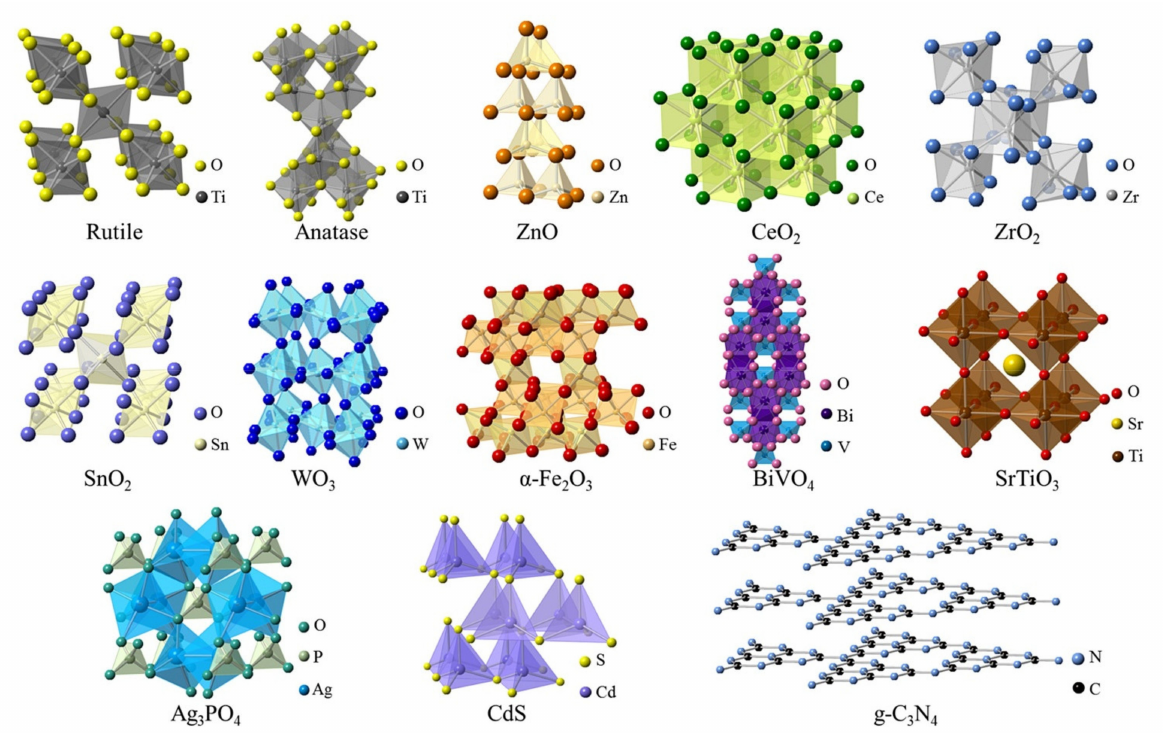
Figure 5. Structures of commonly used photocatalytic materials. Reprinted from [80] with permission from